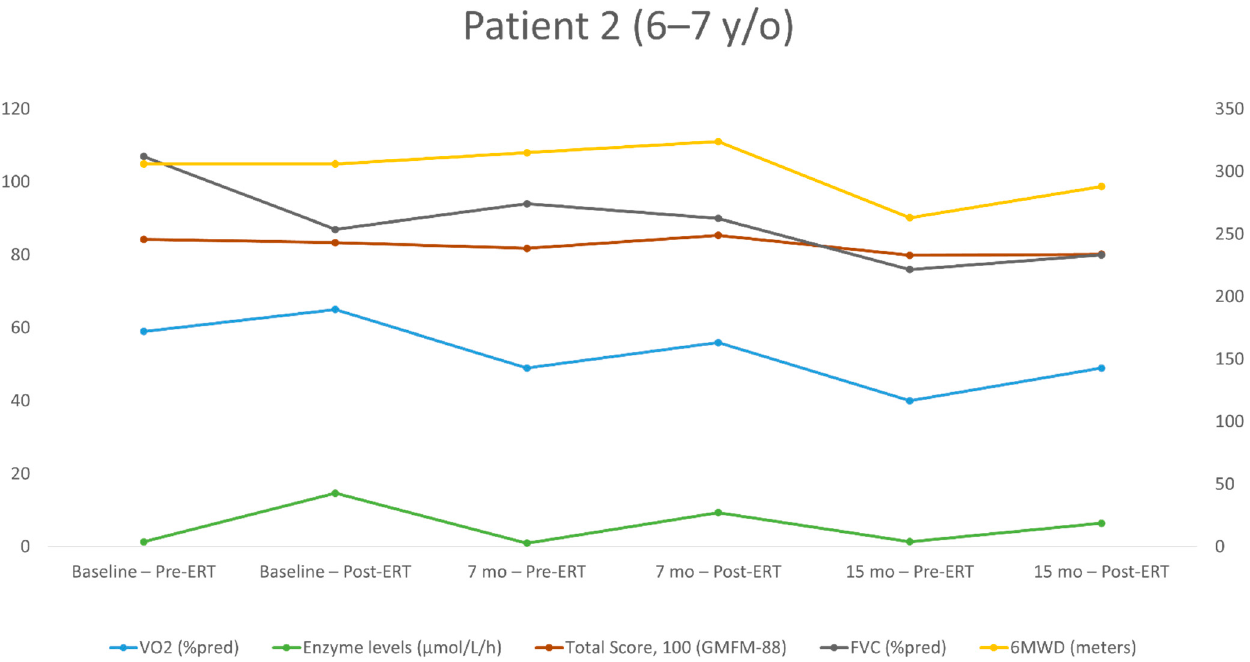
Figure 1. Long-term follow-up of the study parameters (patient 1). y/o = year old, VO 2 = peak oxygen uptake at the peak of exercise; %pred = % of the predicted value; FVC = forced vital capacity; 6MWD = 6-min walking distance.